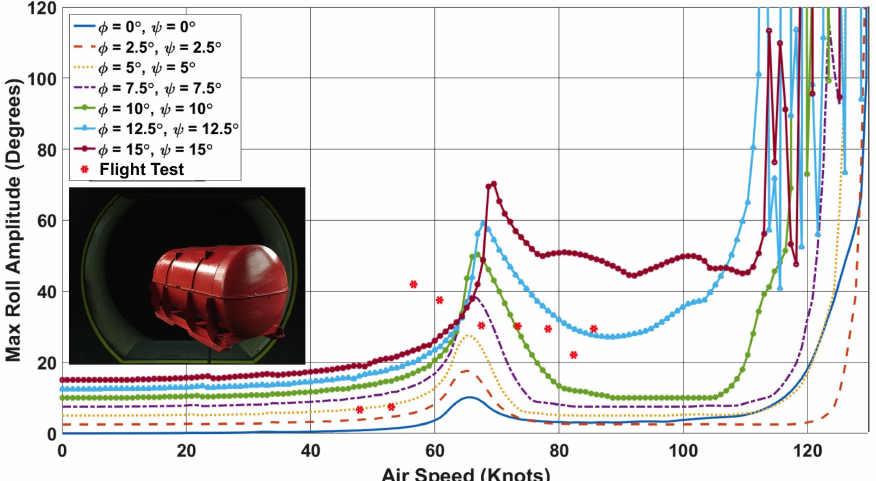
Figure 7. Maximum roll amplitude versus flight speed for an empty engine container, predicted by dynamic simulation with model-scale wind-tunnel aerodynamic data, compared to flight test points. From [100] by permission of